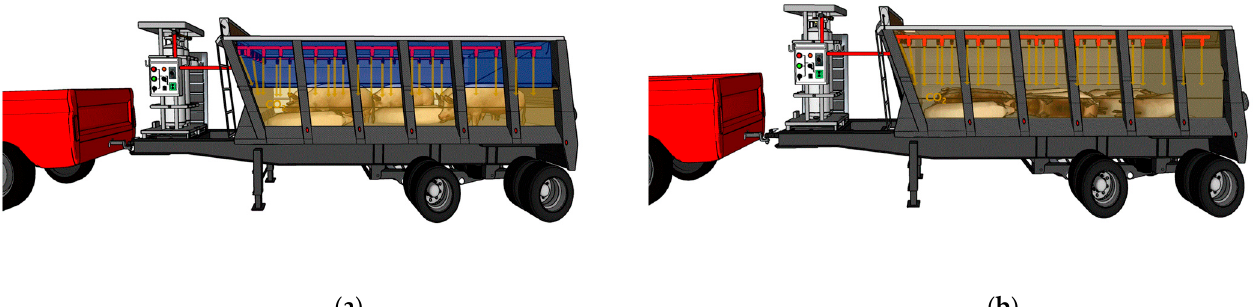
Figure 2. Schematic of liquid CO 2 injection, vaporization, and breathing air replacement. ( a ) Initial phase: within the first minute of CO 2 injection. The bottom brown layer of CO 2 gas continues to fill the mobile trailer with CO 2 . The blue layer on the top is the breathing air that CO 2 displaces. Pigs lying on the floor represent the loss of consciousness/mortality. ( b ) Final phase: within the first 5 min of CO 2 injection. All volume of the covered trailer is filled with CO 2 . All pigs are dead and ready for thermal treatment and pathogen inactivation.